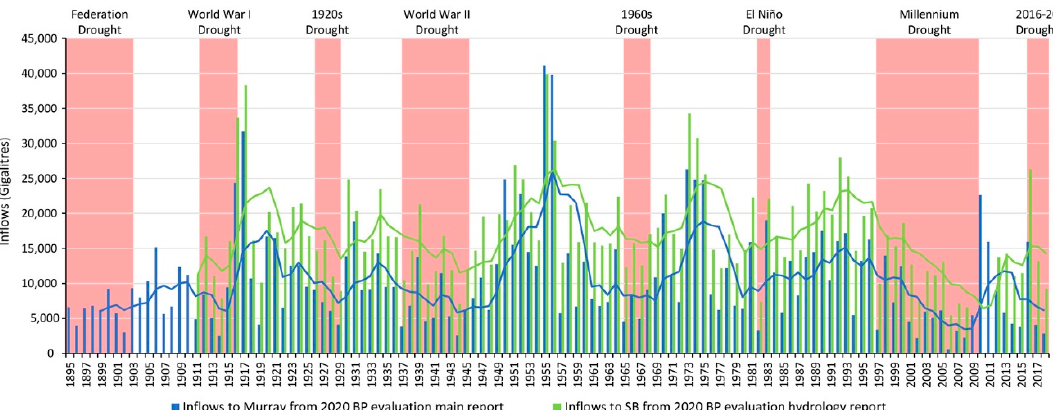
Figure 3. Inflows to the Murray and southern Basin (SB) from the 2020 Basin-Plan Evaluation Report [12] and the 2020 Basin Plan Evaluation Hydrological Analysis Evidence Report [41] and data dashboard [40], with five-year moving averages and the eight periods of major drought between 1895–2018 (data from [43]). The average inter-drought period is 9 years 11 months. Note the cyclic inter-decadal variability between drought and wetter periods and also that data is missing for the years 2009–2011 from the hydrological analysis evidence report.